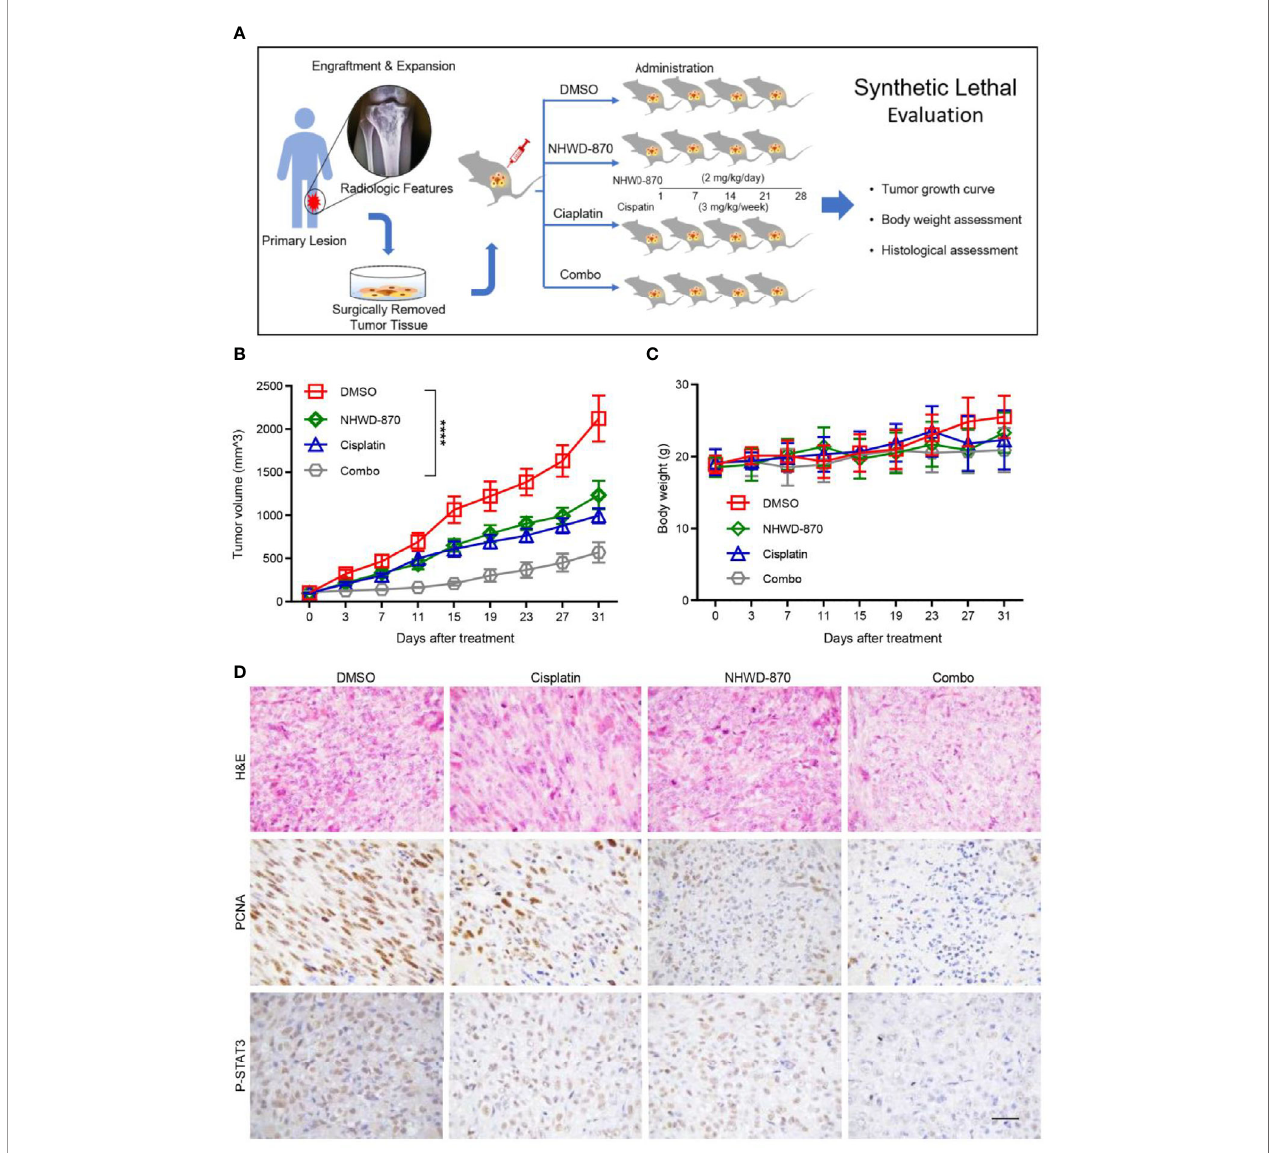
FIGURE 7 | NHWD-870 sensitizes cells to cisplatin in a preclinical osteosarcoma PDX model. (A) Flowchart of our in vivo drug validation study. (B) Daily changes in tumor volume demonstrated that the combination of NHWD-870 and cisplatin enhanced the inhibition of osteosarcoma in vivo . (****P < 0.0001). (C) Daily change in the body weight of the PDX model in each group. (D) Histological malignancy reduction of osteosarcoma tissue under the enhanced inhibition of the drug combination was detected by H&E, and the relative decreased activation of proliferation-associated antigens and STAT3 was detected by immunohistochemistry. Scale bar = 50 m